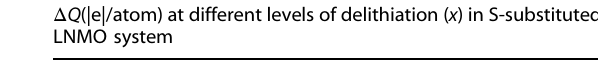
Table 1. Change of atomic charge ( Δ Q ) for the S-substituted LNMO (003) surface at different delithiation